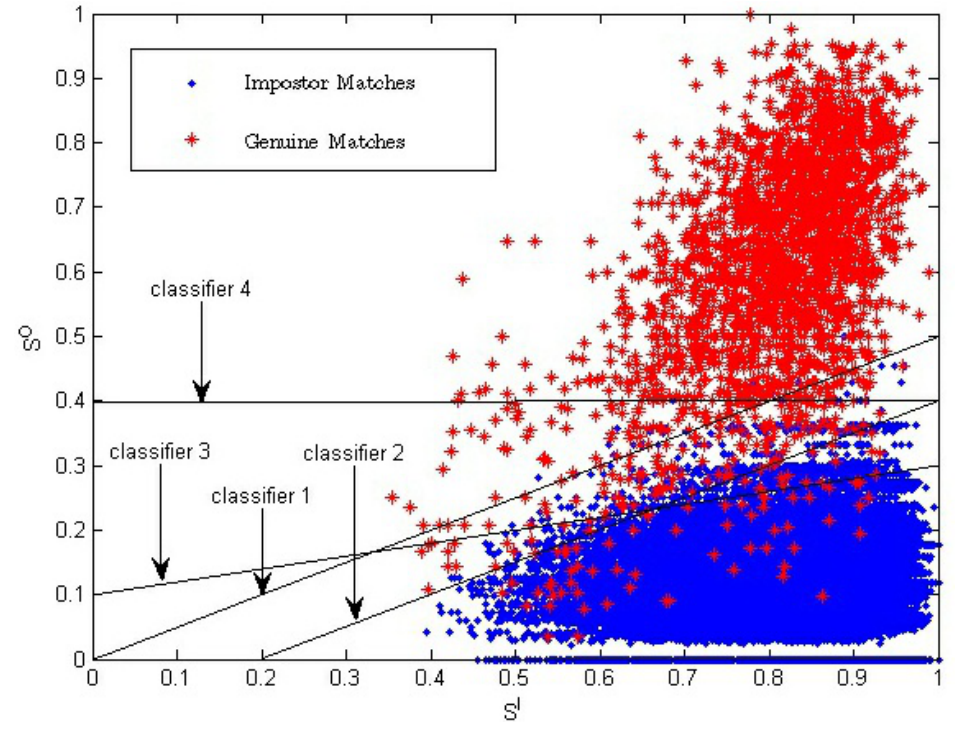
Example of classifiers of the proposed video-based method and the single impression-based method. Classifiers 1 to 3 are examples of the classifiers used in